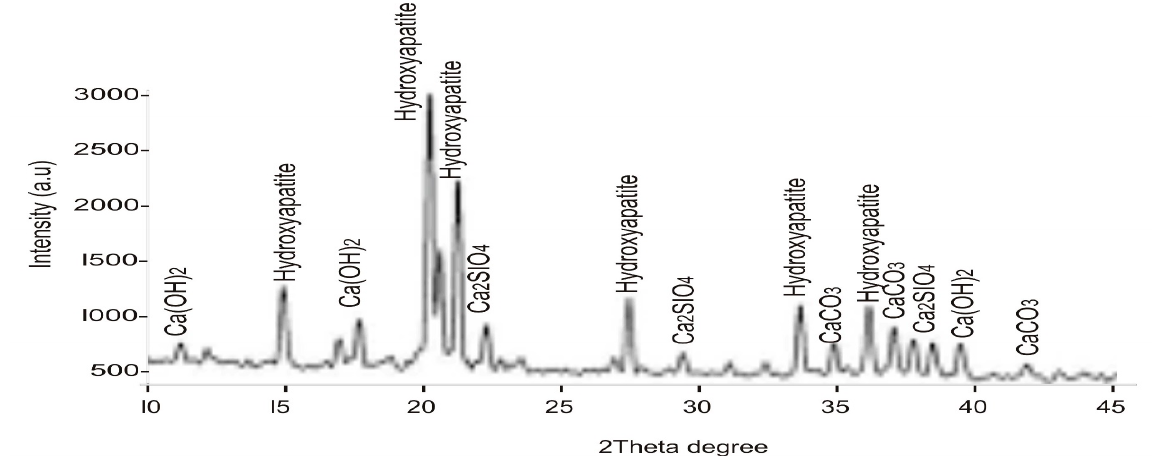
Figure 3. XRD pattern of SPs.